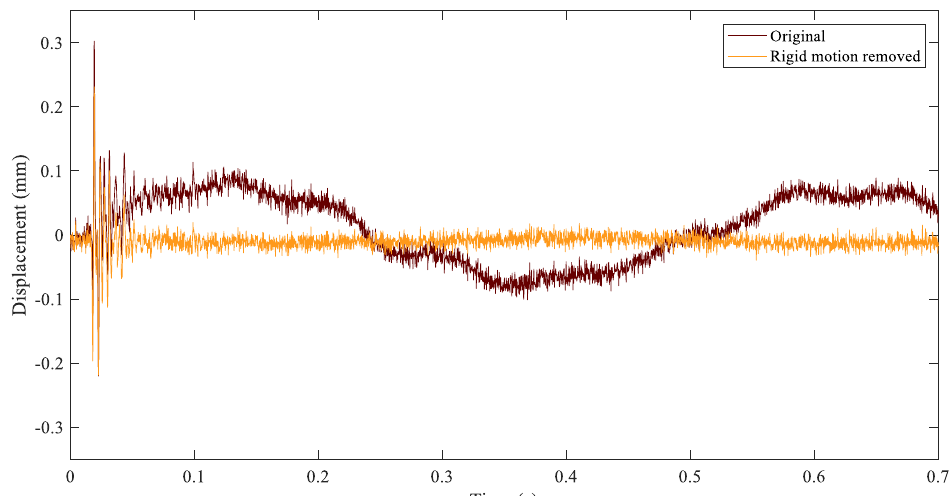
Figure 4. Raw out-of-plane displacement evolution of a point in the middle of the panel and the resulting evolution after removing the rigid body motion.